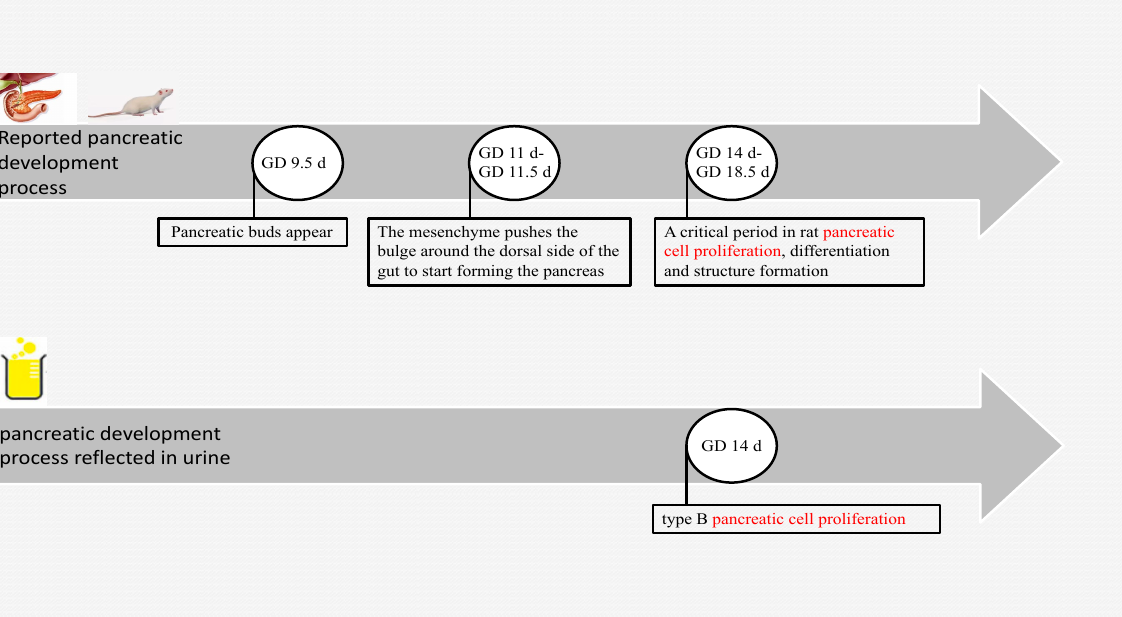
Figure 4. Fetal rat heart development. The above is the reported heart development process. The following are cardiac developmental processes enriched by changing urinary proteomes.